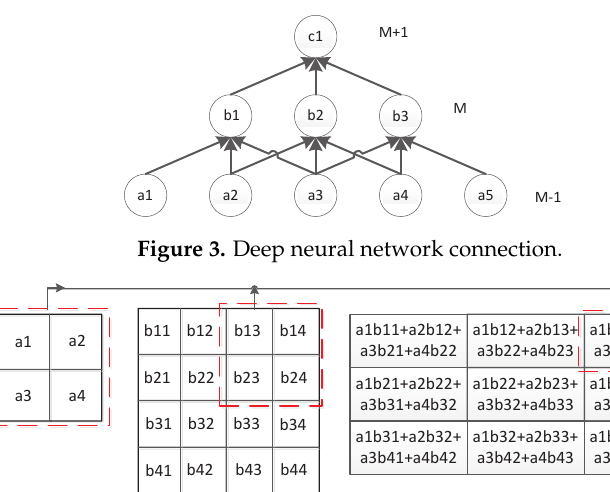
Figure 4. Weight calculation process.